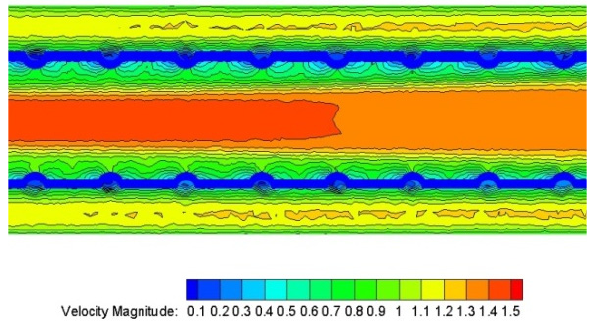
Figure 4. Velocity distribution diagram in and outside the tube.